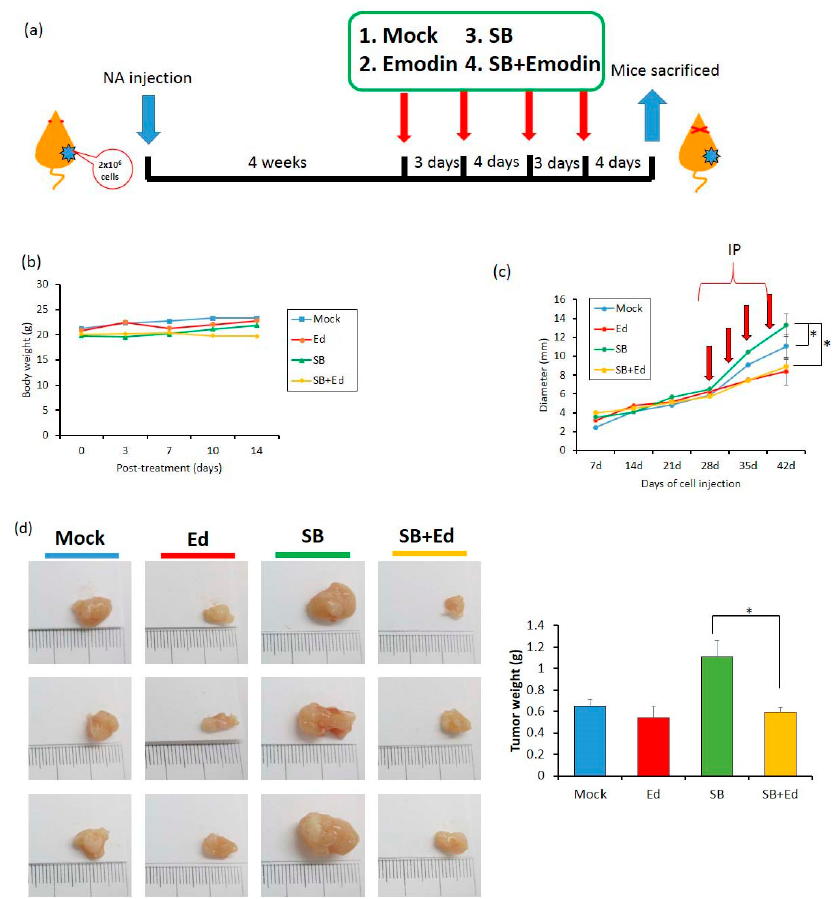
Figure 8. Emodin represses the tumor growth in a mouse model. NA cells were prepared for subcutaneous inoculation into severe combined immunodeficient (SCID) mice, which then received various treatments. ( a ) The diagram presents the schedule for in vivo assay of EBV reactivation inhibited by emodin. ( b ) The average animal body weights during the experiment were measured ( n = 6 mice for each group). ( c ) The diameters of tumor nodules were monitored weekly using calipers throughout the experiment. ( d ) The tumor weights were measured after the mice were sacrificed. Tumor nodules were photographed as the listed pictures. Data are presented as mean ± SD. * p <